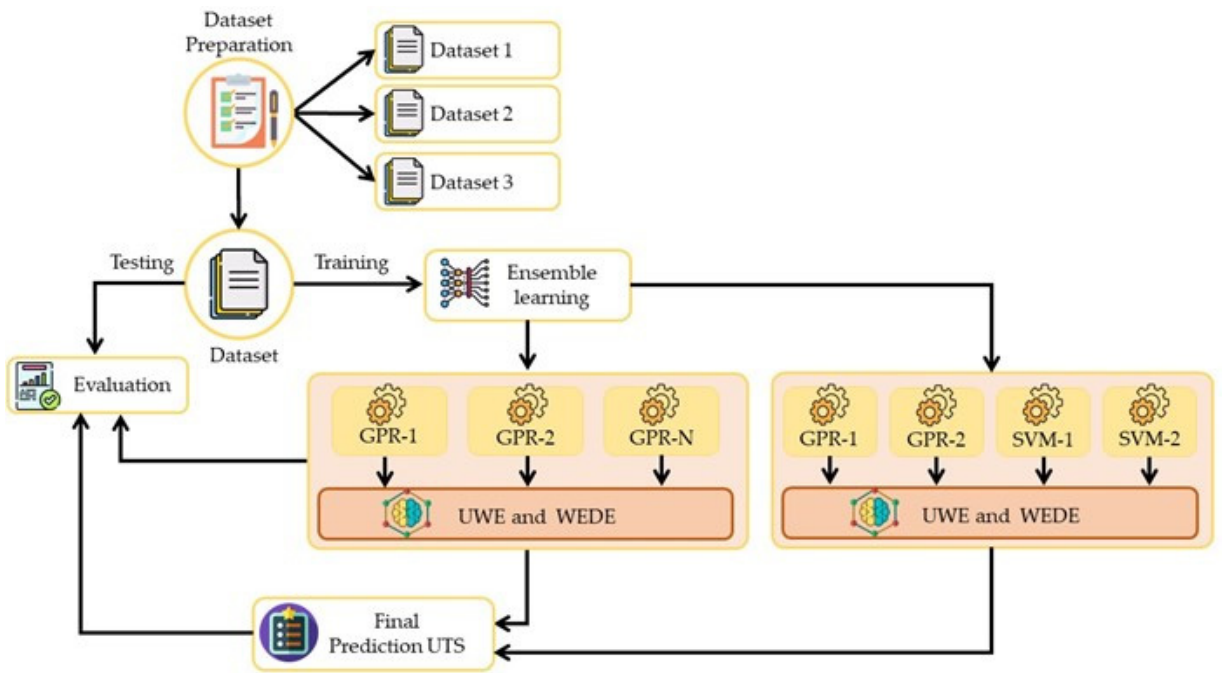
Figure 1. The framework of the proposed model used to predict the UTS.